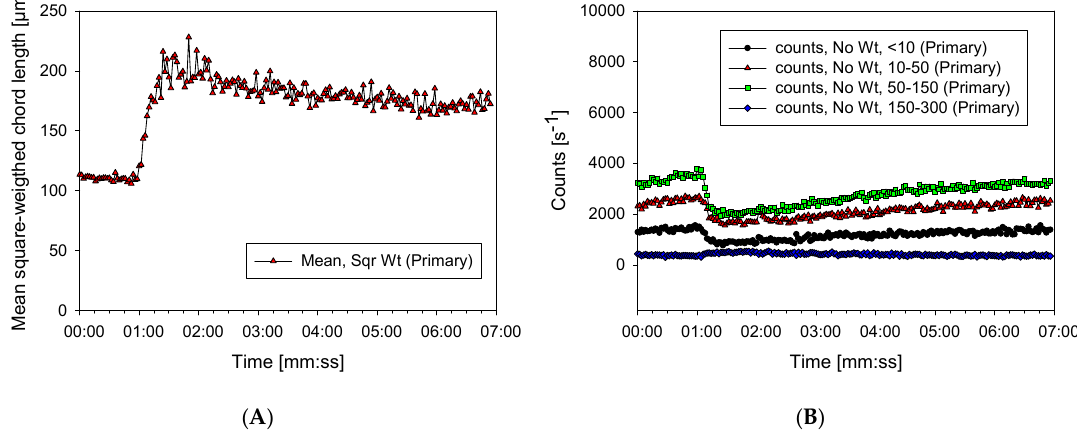
Figure 6. ( A ) Mean square chord length and ( B ) counts evolution of suspension; 100 ppm of guar gum added after 1 min (no frother or collector).